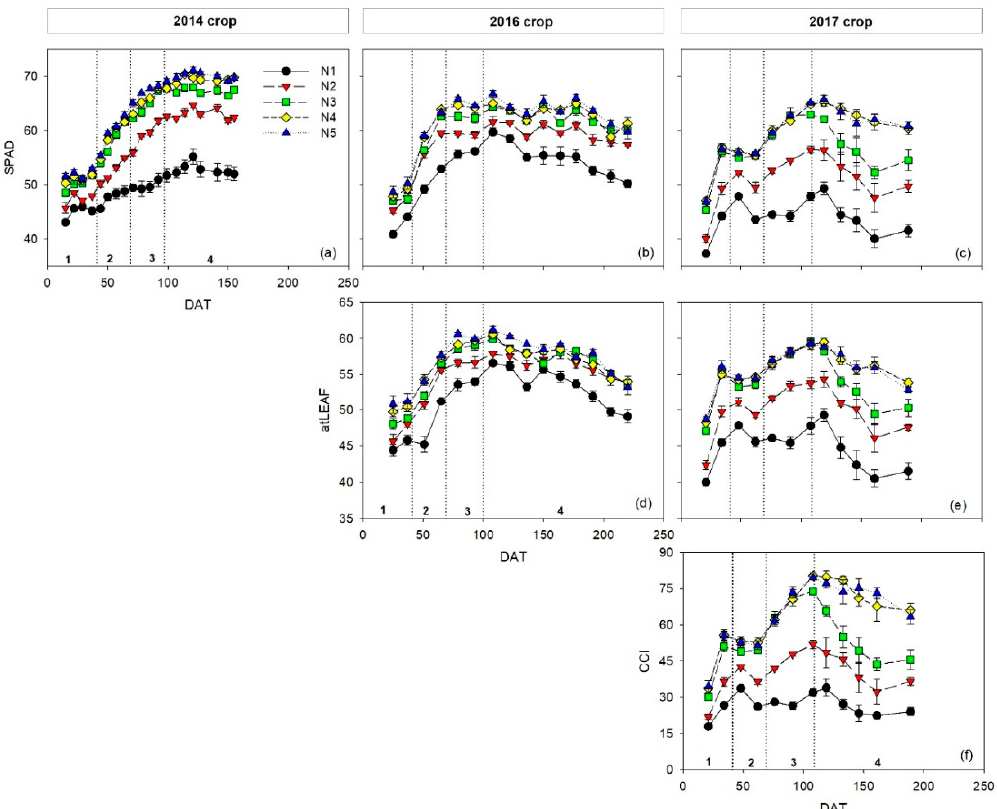
Figure 2. Temporal dynamics of chlorophyll meters measurements of SPAD values ( a – c ), atLEAF values ( d , e ), and CCI values ( f ), for the sweet pepper ( Capsicum annuum ) crops subjected to five di ff erent N treatments with four repetitions. Vertical dotted lines and numbers represent the di ff erent phenological stages: 1—vegetative, 2—flowering, 3—early fruit growth, 4—harvest. Values are means (n = 4) ± standard error (SE). DAT is days after transplanting.